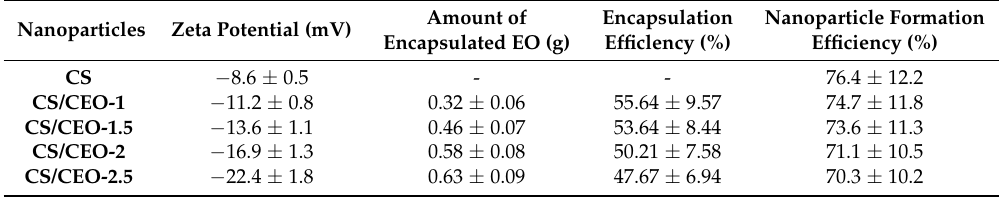
Table 1 . The characteristics of cinnamon essential oil (CEO)-loaded chitosan (CS) nanoparticles.